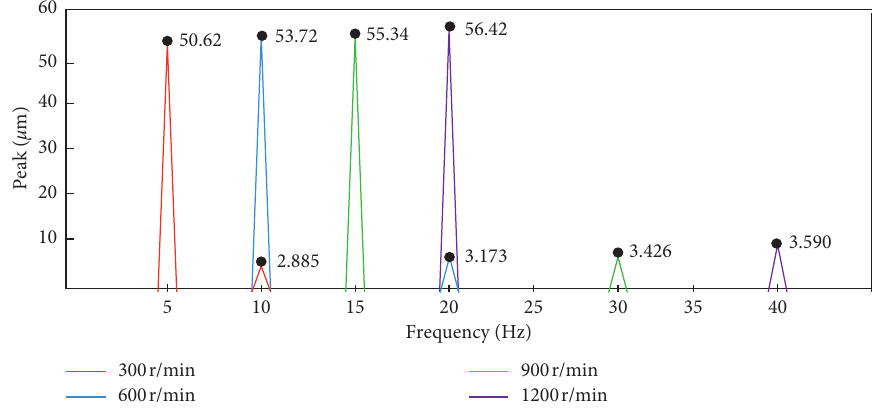
Figure 22: FFT diagram at different speeds.